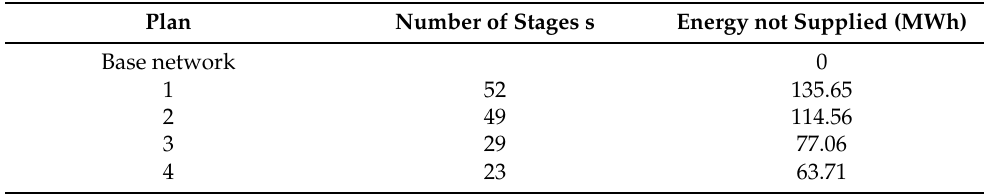
Table 2. Energy Not Supplied for each recovery plan.